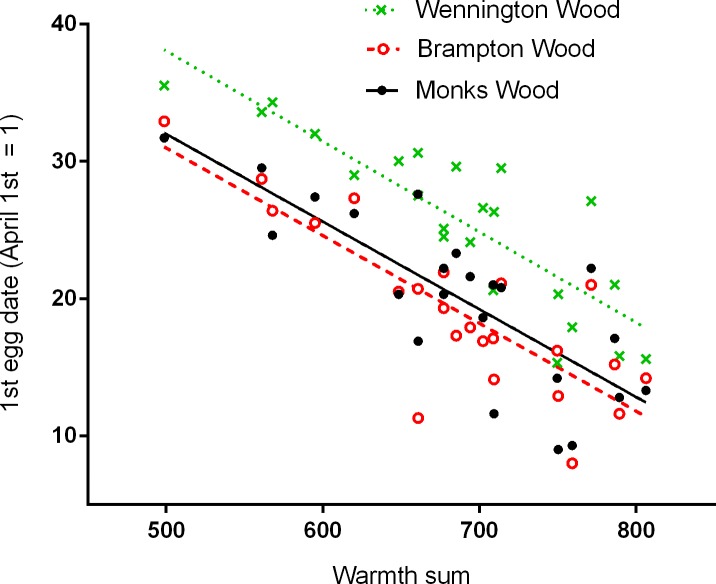
Relationships between timing of breeding (1st egg dates) and local spring warmth (warmth sum).Larger values of the warmth sum reflect warmer springs and earlier laying. Least squares regression equations are: MW 1st egg date = 63.9–0.0639 warmth sum, R2 = 0.640, P < 0.001; BW 1st egg date = 62.9–0.0639 warmth sum, R2 = 0.681, P < 0.001; WW 1st egg date = 71.0–0.0659 warmth sum, R2 = 0.739, P < 0.001.